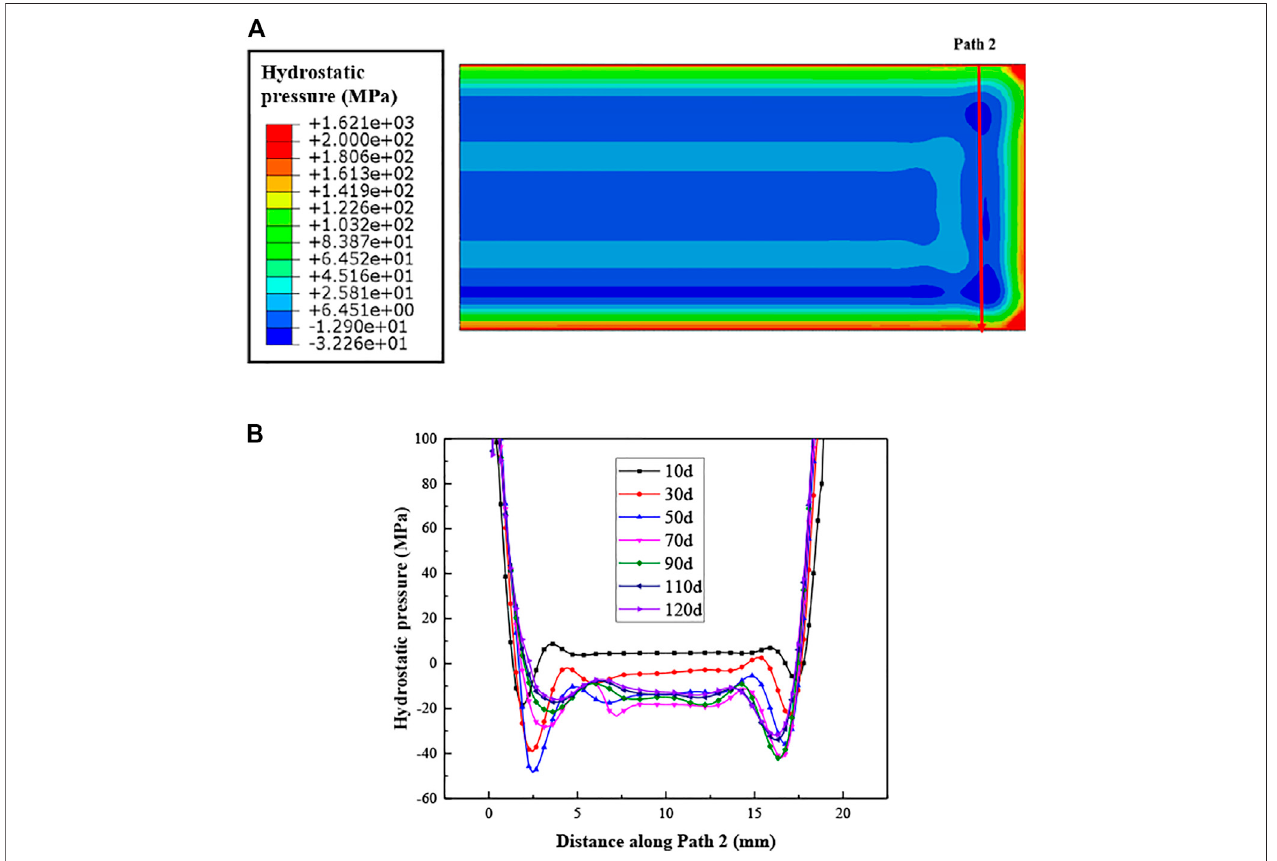
FIGURE 12 | (A) Distribution of the hydrostatic pressure (the upper side has a larger fi ssion rate) and (B) evolution of the hydrostatic pressure along Path 2.